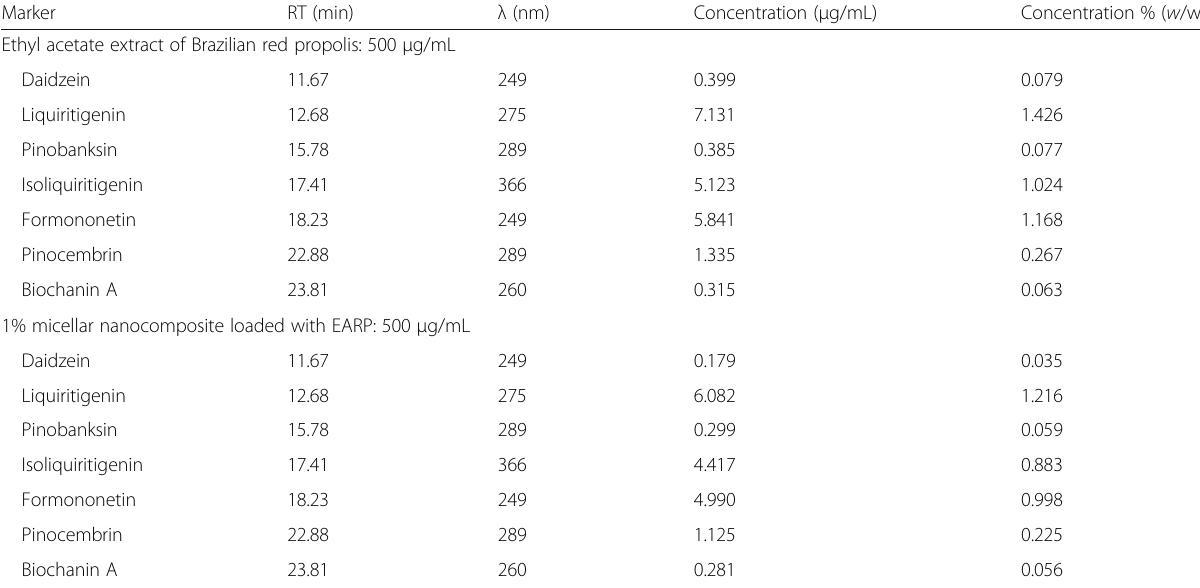
Table 1 Chromatographic parameters: retention times (RT), maximum wavelength, and concentration of ethyl acetate extract of Brazilian red propolis and 1% of the micellar nanocomposite loaded with EARP using UPLC-DAD Marker RT (min) λ (nm)